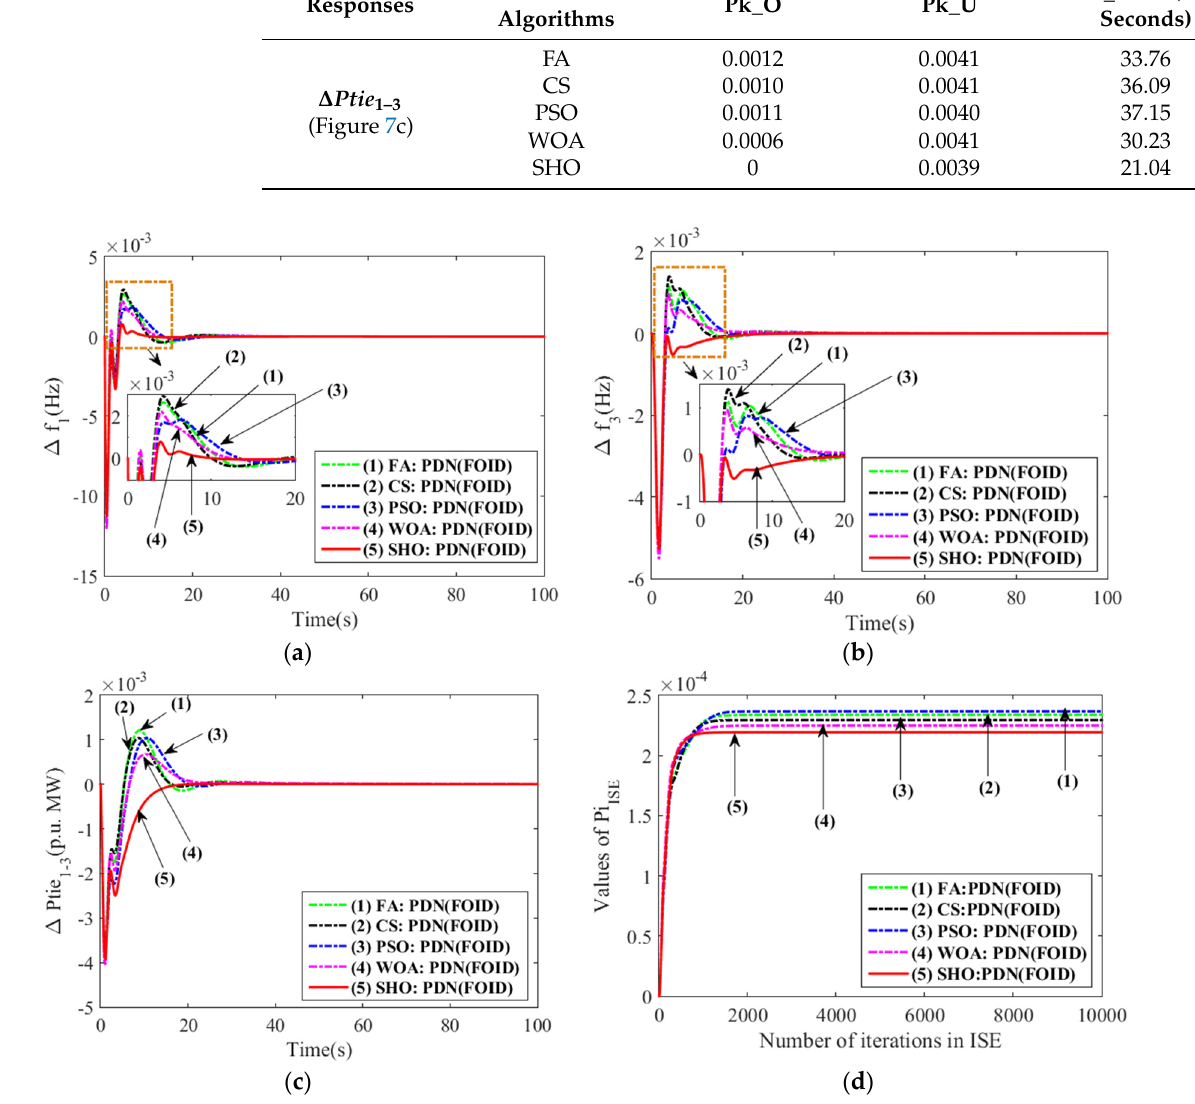
Figure 7. Evaluation for the recommendation of algorithm amid FA/CS/PSO/WOA/SHO techniques for obtaining finest values of PDN(FOID) controller for scheme-1 contrast time: ( a ) Anomaly of frequency in area-2, ( b ) Anomaly of Tie-line power interlinking area-1 and area-2, ( c ) Anomaly of Tie-line power interlinking area-1 and area-3, ( d ) Convergence curve.